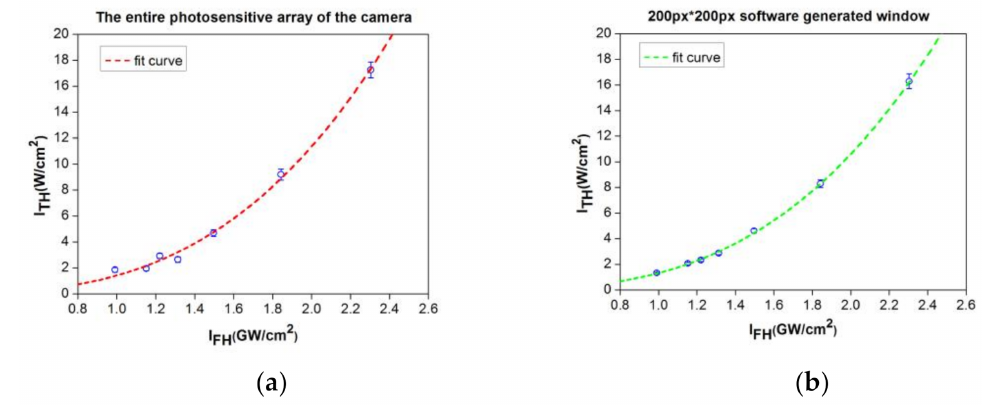
Figure 8. The experimental curves I TH,peak ( L ) = f ( I FH,peak (0)), considering the entire photosensitive array of the camera ( a ), and a 200 px * 200 px software generated window surrounding the measured beam spot ( b ),